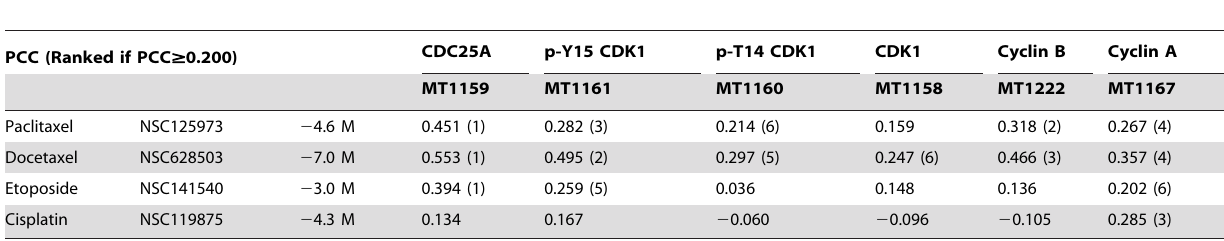
Table 3. Correlation between CDK1 activating machinery components and chemotherapeutic agents in NCI60 cell line panel.